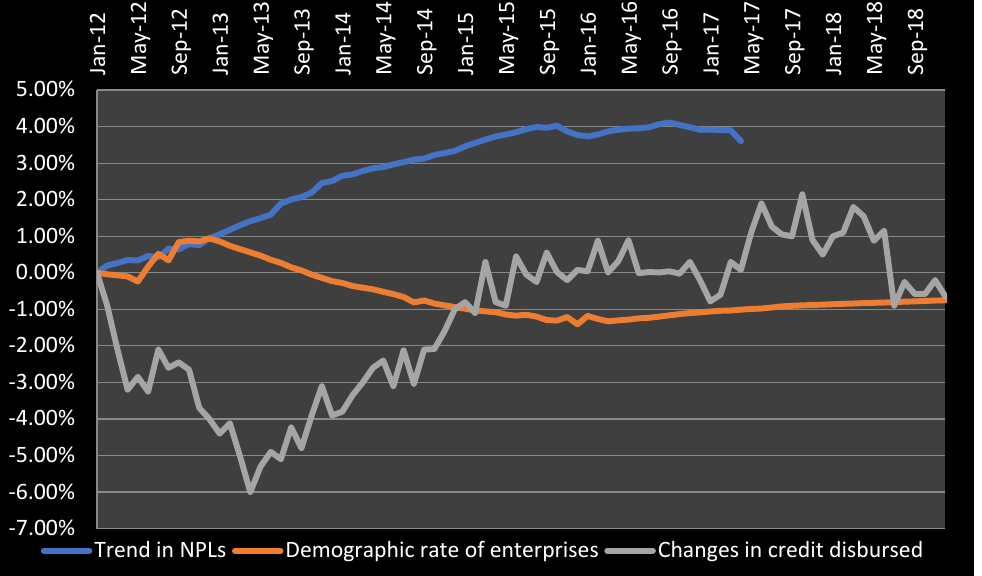
Figure 1. Changes in credit disbursed, population of enterprises in the market and number of NPLs in Italy from January 2012 to September 2018. The graph shows a general upward trend of 4.00% in NPLs from January 2012 to May 2017. There is a rise of 1.00% in enterprise population from January 2012 to January 2013, followed by a decline of 2.00% and stagnation until September 2018. Credit disbursement sees a sharp decline of 6.00% from January 2012 to May 2013, recovering gradually to reach original levels in 2015 and increasing a further 2.00% in 2017, before dropping back in 2018. Based on data in Tables 1–5. Table 6. Gross lending to enterprises in the United Kingdom, in billions of pounds (September 2010–June 2019).